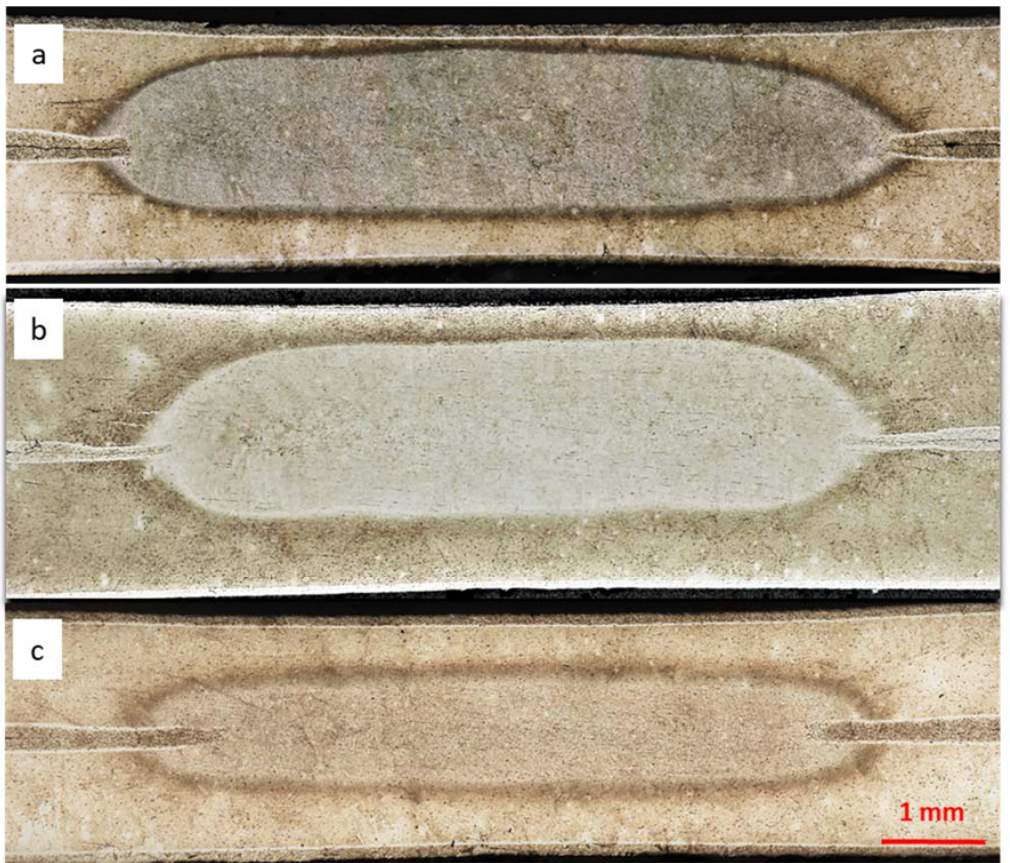
Figure 5. The microstructure of resistance spot welds made on the plates, with different surface preparation: ( a ) etching before welding, ( b ) etching and primer coating before welding, ( c ) etching before welding, and application of adhesive in the area of the overlap after welding.